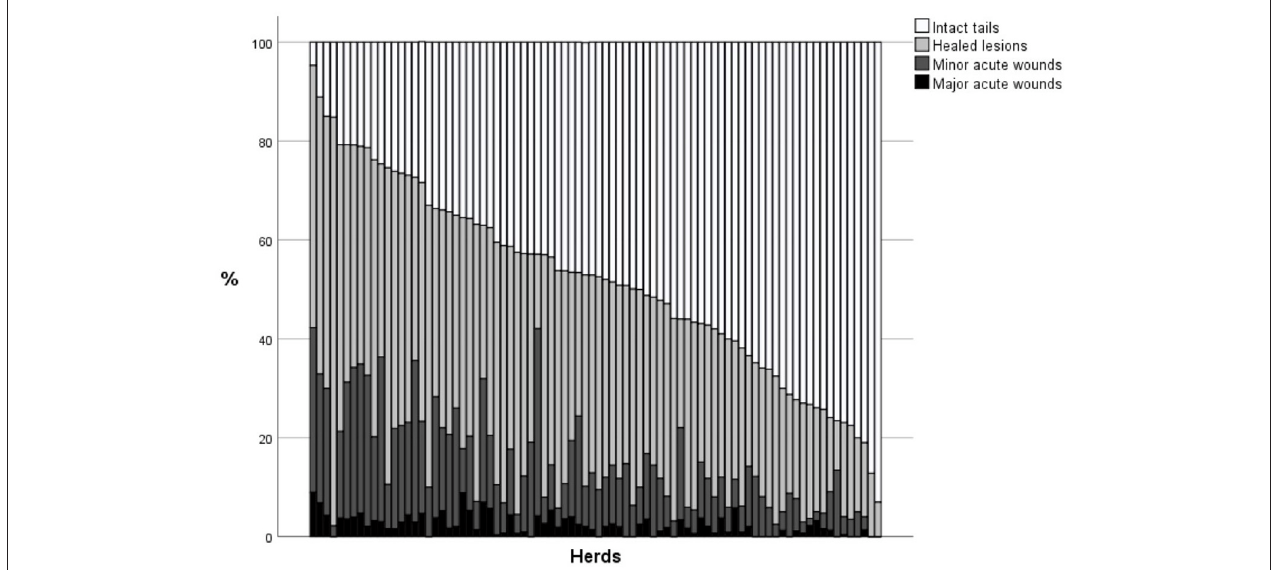
FIGURE 2 | Study herds ( n = 84) organized according to classification of the undocked tails of their finishing pigs in slaughterhouse: percentage of intact tails, tails with healed lesions, tails with minor acute wounds, and tails with major acute wounds ordered according to increasing proportion of intact tails.